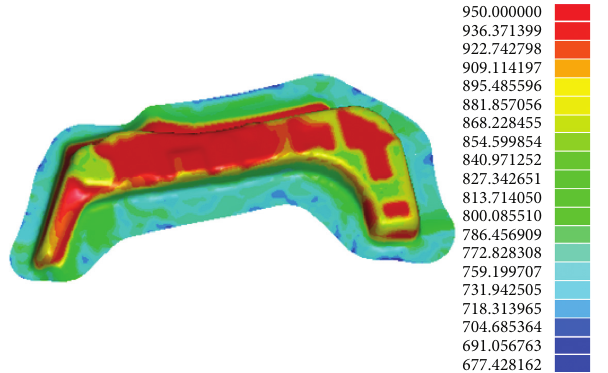
Figure 3: Temperature field distribution of